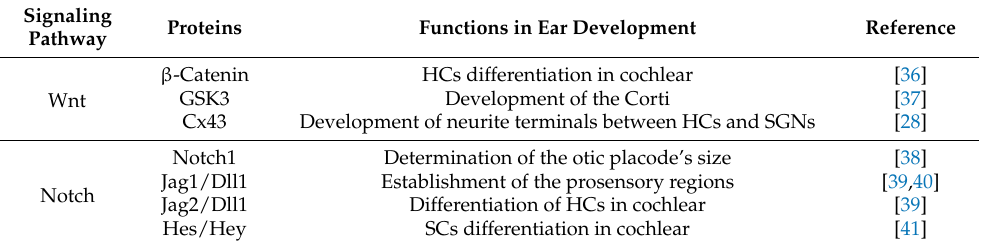
Table 1. Molecules of the Wnt and Notch signaling pathways involved in inner ear development.